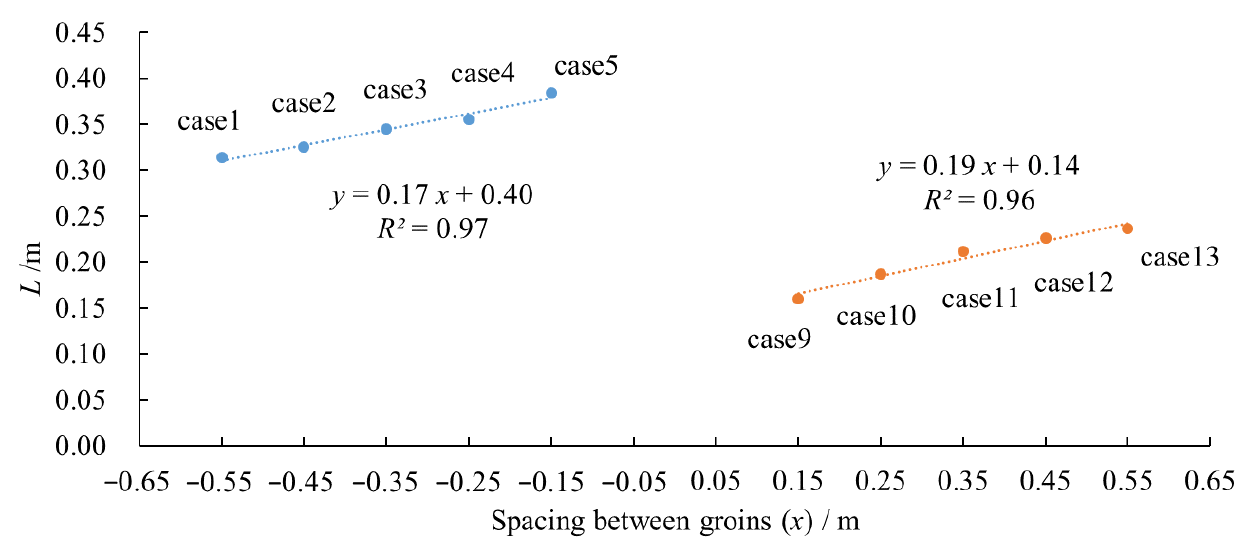
Figure 8. Relationship between the recirculation length behind Groin A ( L ) and the spacing between groins ( x ) for cases 1–5 and cases 9–13, respectively.